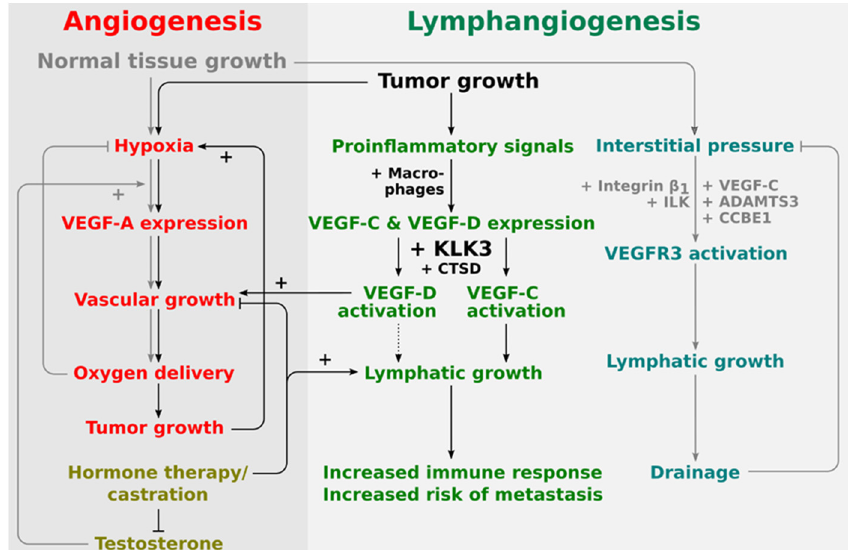
Figure 2. Proposed placement of KLK3 into the regulatory network of angiogenesis and lymphangiogenesis. The central stimulus for both physiological and pathological angiogenesis is hypoxia. Therefore, tumor and physiological angiogenesis share common regulatory pathways. Lymphangiogenesis in physiological and pathological settings appears to be quite differently regulated. During development, lymphangiogenesis is stimulated by the interstitial pressure which amplifies VEGFR-3 signaling via a β 1-integrin/ILK-assisted mechanism. In the tumor setting, on the other hand, tumor-infiltrating macrophages are major producers of both VEGF-C and VEGF-D. Activation of VEGF-D by KLK3 and CTSD does generate a predominantly angiogenic mature VEGF-D, while activation of VEGF-C does generate a predominantly lymphangiogenic mature VEGF-C. VEGF-D can therefore replace VEGF-A (rendering anti-VEGF-A treatments ineffective), while VEGF-C leads to the ambivalent outcome of increased immune response and increased likelihood of metastasis.